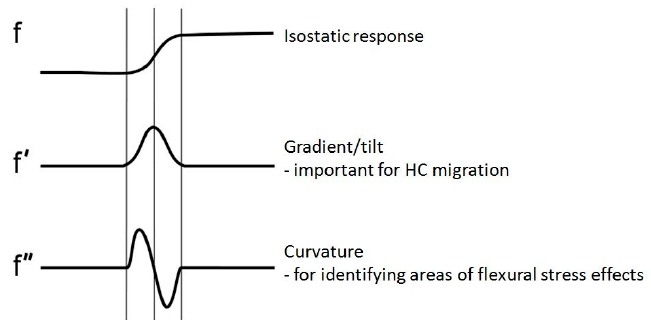
Figure 5. Derivative of the glacial isostasy used to identify areas of high flexural stresses.